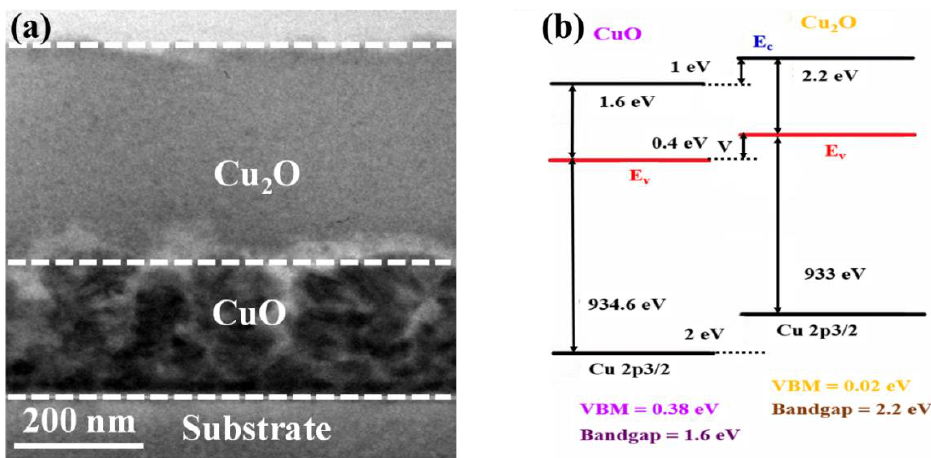
Figure 1. ( a ) Cross-sectional TEM image and ( b ) band alignment of the fabricated heterojunction CuO–Cu 2 O thin film photocatalyst.